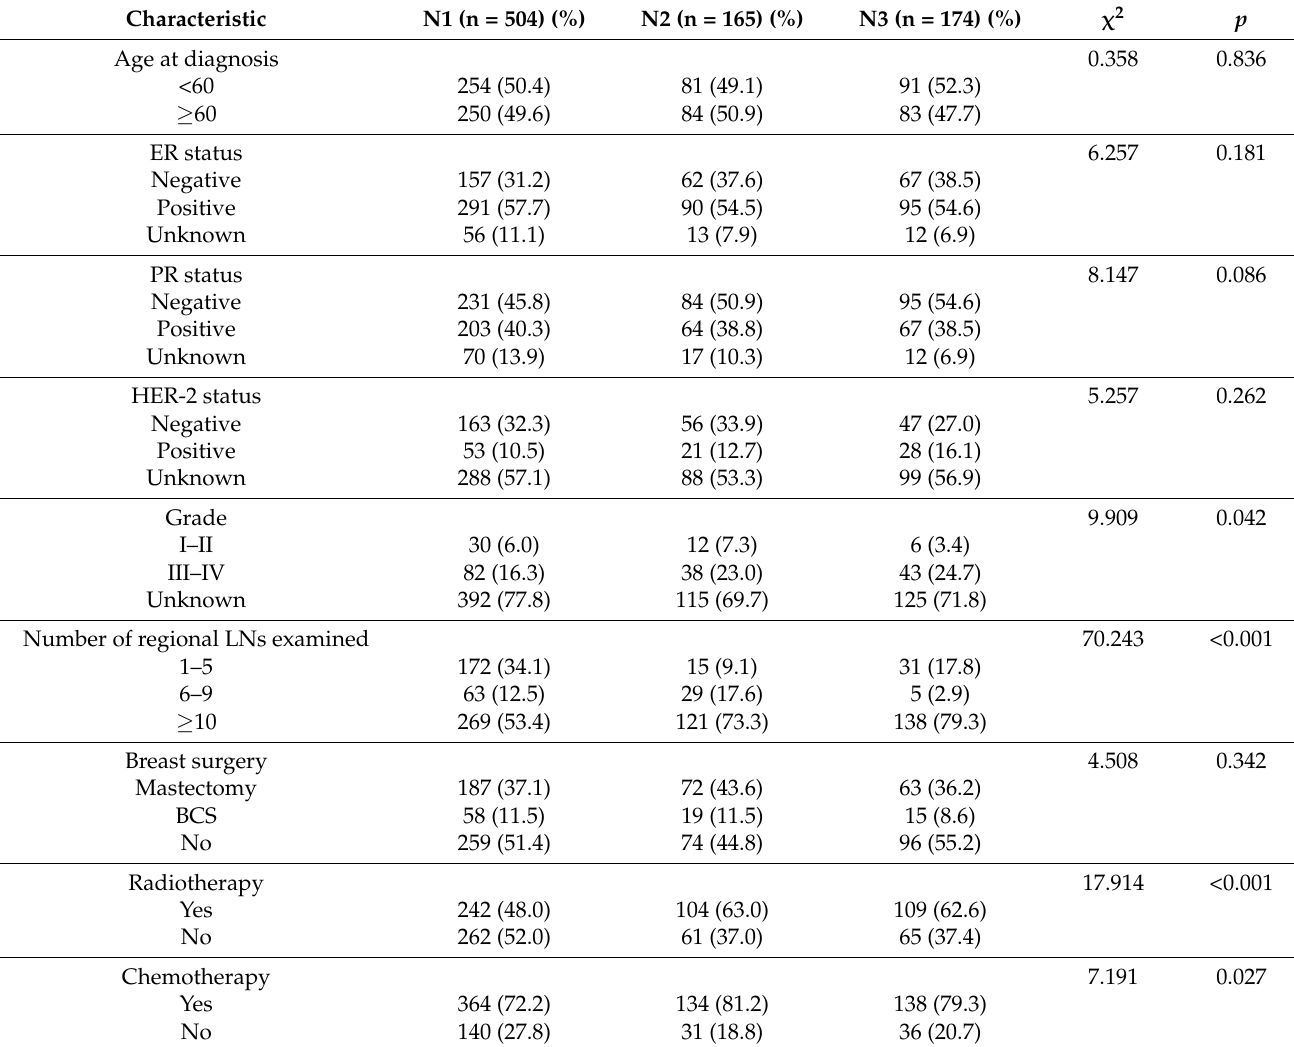
Table 2. Comparison of different N staging outcomes in occult breast cancer